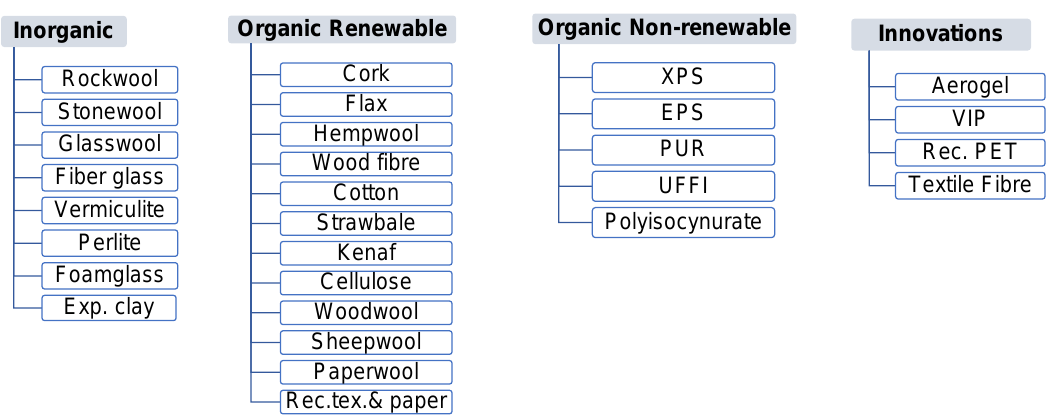
Figure 1. Thermal insulation materials under consideration in this study.